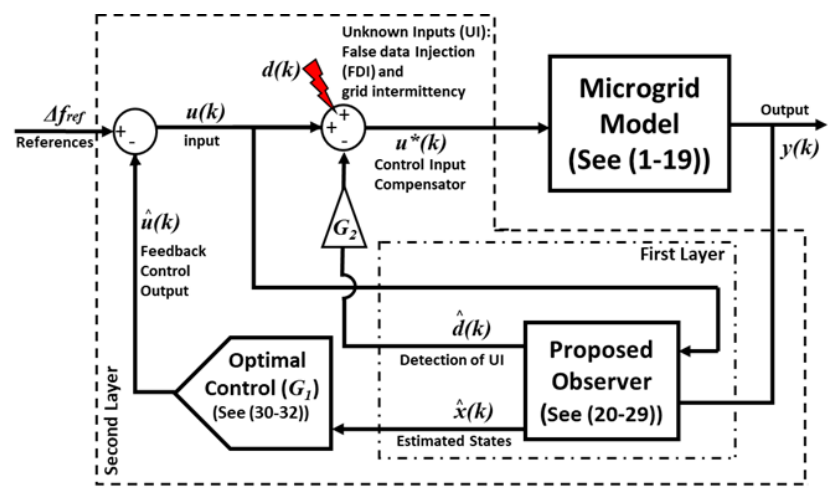
Figure 4. The proposed control strategy for islanded